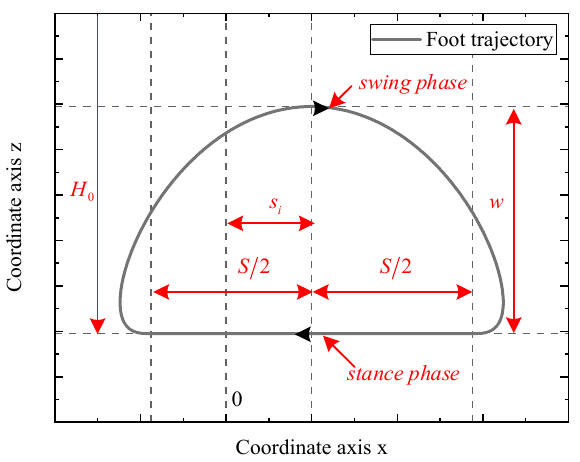
Figure 8. Foot trajectory curve of HHR. Table 4. Position, velocity, and acceleration constraints in foot